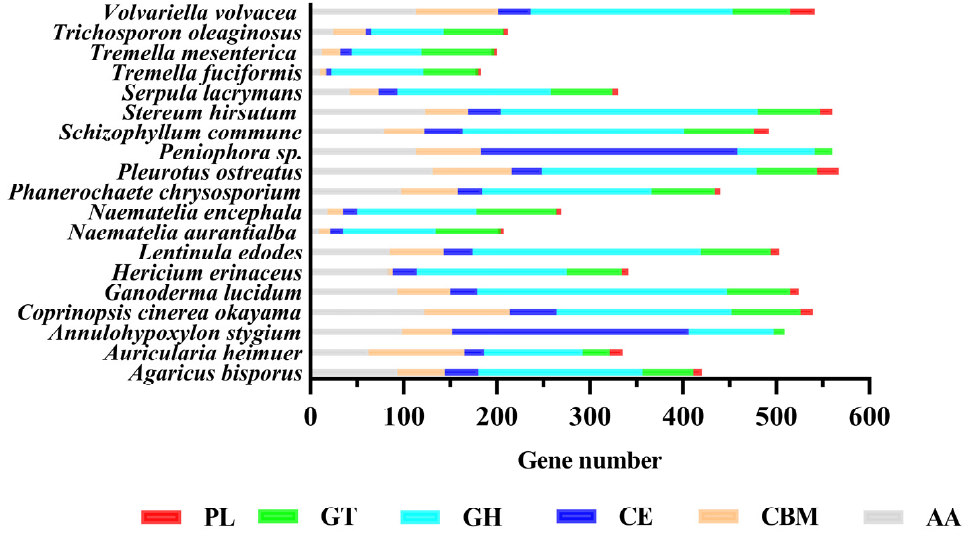
Figure 2. The number of CAZymes genes in N. aurantialba and the other 18